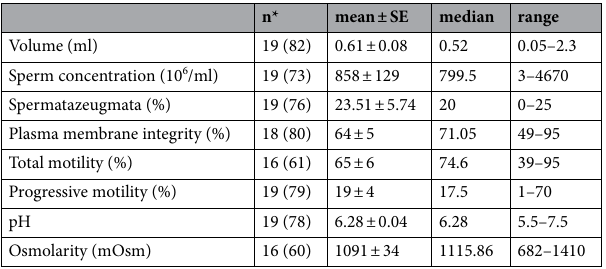
Table 1. Whitespotted bamboo shark Chiloscyllium plagiosum semen characteristics. *Sharks